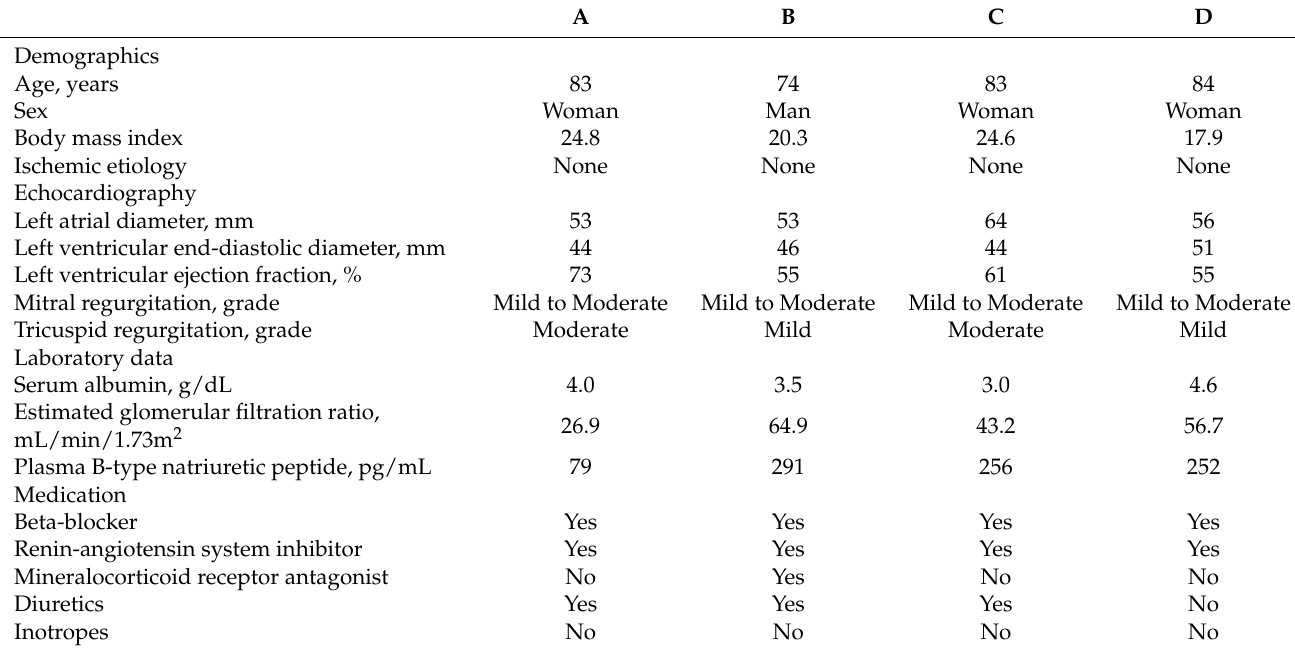
Table 1. Baseline